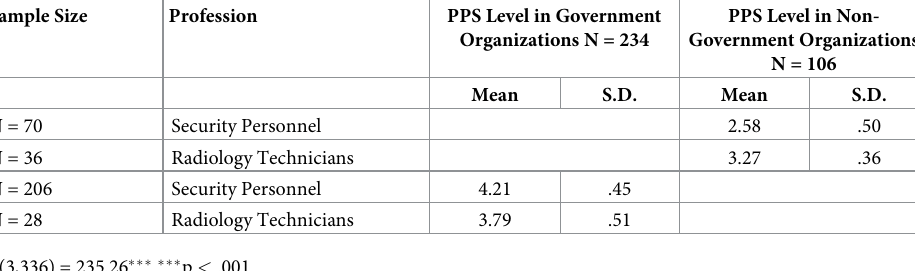
Table 3. Means and S.D. of perceived publicness across ownership and profession. Sample